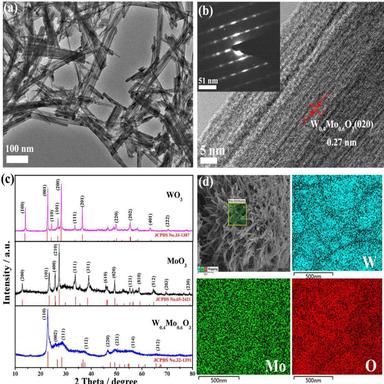
(a) TEM image and (b) HR-TEM (with SAED insert) image of the W0.4Mo0.6O3 nanoneedle arrays, (c) XRD patterns of the WO3 nanoparticles, the MoO3 nanoparticles, and the W0.4Mo0.6O3 nanoneedle arrays, (d) Element mapping images of the W0.4Mo0.6O3 nanoneedle arrays.